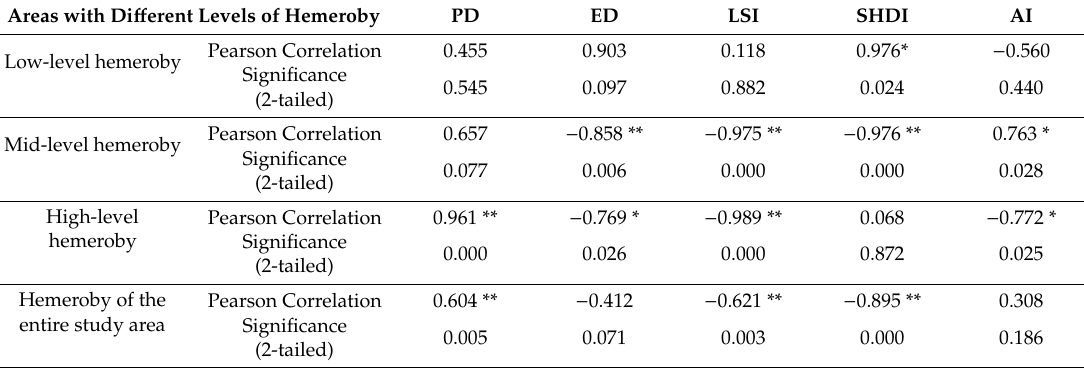
Table 6. Correlation matrix between hemeroby and landscape pattern